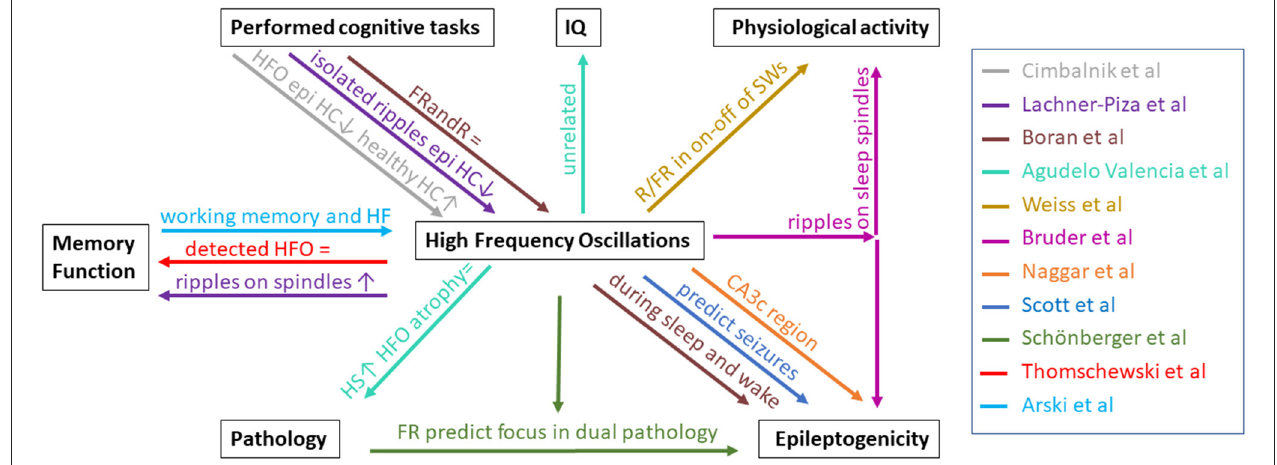
FIGURE 1 | Overview of relationships between HFO and pathology, memory function, performed cognitive tasks, IQ, physiological activity, and epileptogenicity described by the papers in this Research Topic. Each paper is represented by a color. HS, hippocampal sclerosis; HC, hippocampus; epi, epileptic; FRandR, fast ripples combined with ripples; R, ripple; FR, fast ripple; SW, slow waves; ↑ , increase/positive relation; = , no effect; ↓ , decrease/negative